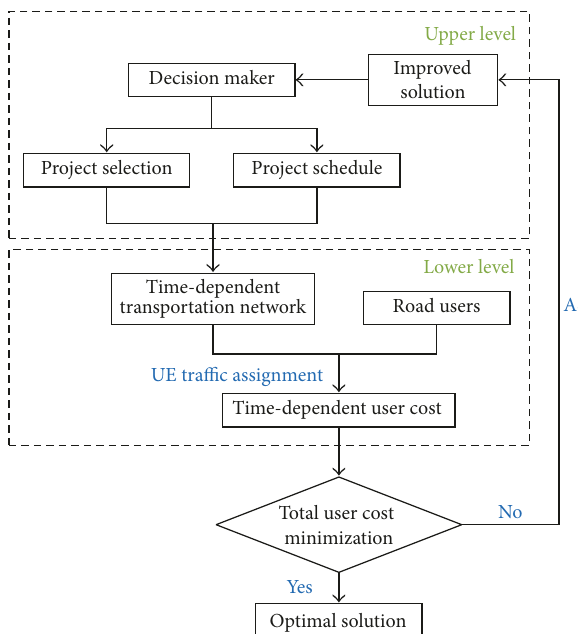
Figure 4: Framework of the T-DNDP model and ASA.